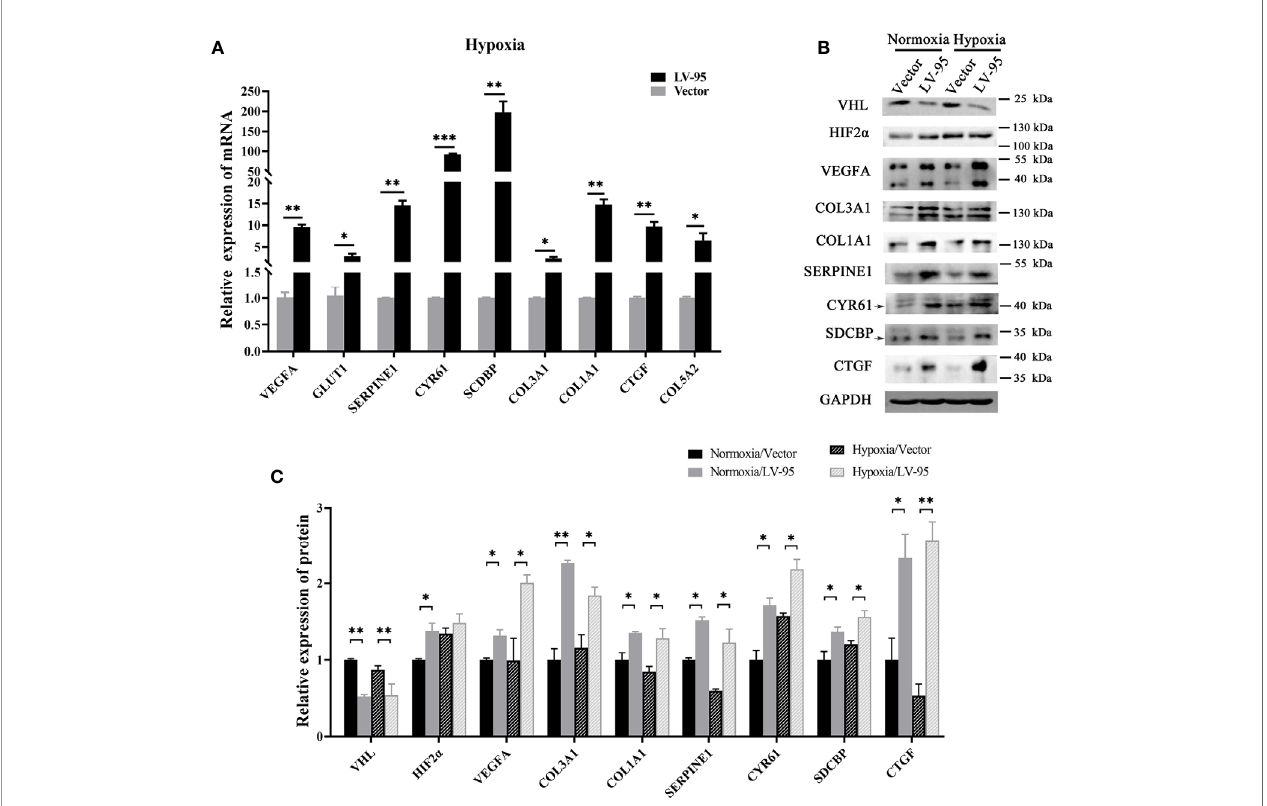
FIGURE 5 | HIF-2 a may mediate the overexpression of these seven genes. (A) The VHL-KD cell line (LV-95) and the empty vector-transfected cell line (Vector) were treated with hypoxia, and then qRT-PCR was used to detect the mRNA expression of seven target genes in the cells (mean ± SEM), n = 3, *P < 0.05, ** P < 0.01, *** P < 0.001. (B, C) The western blot was used to detect the change of protein expression in cells when VHL is knocked down; the histogram indicated the multiple of protein changes (mean ± SEM), n = 3, ** P <